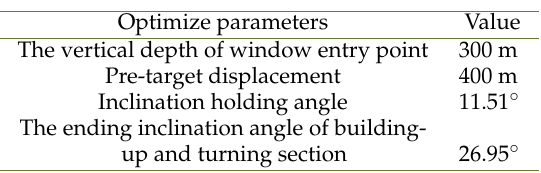
Table 4. Well path design parameters based on shortest